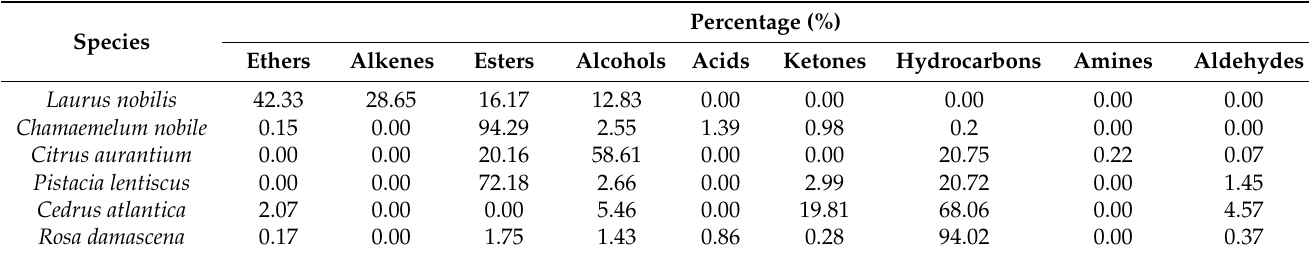
Table 11. Percentage of the chemical family composition of EOs of plants